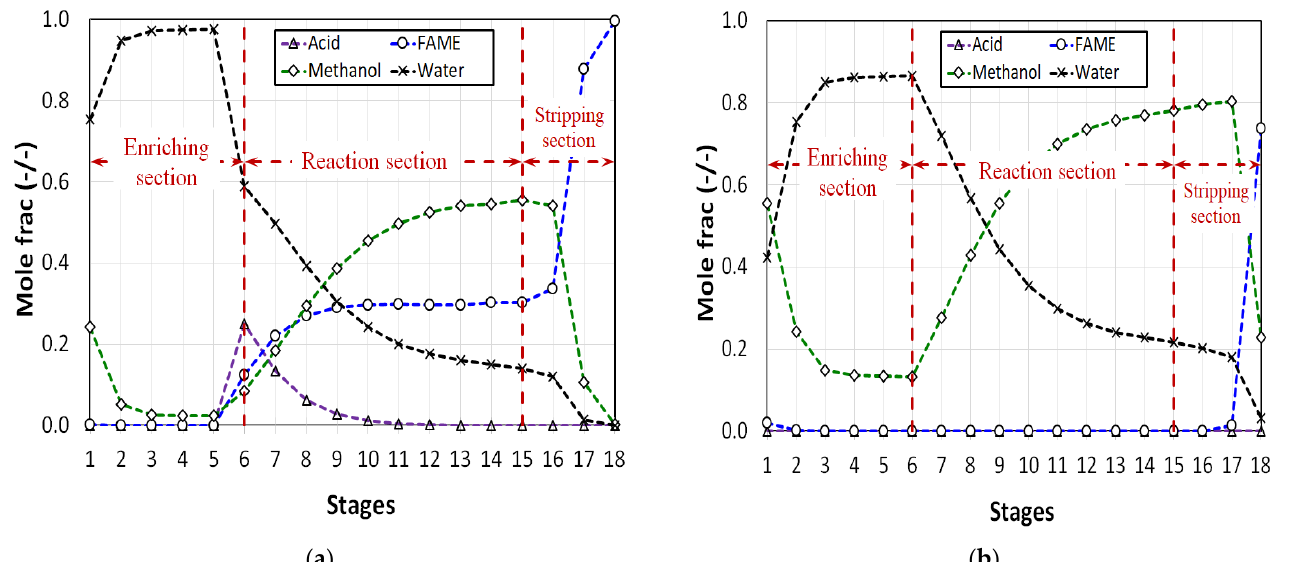
Figure 4. Stage composition profile of RD-column. ( a ) Liquid phase. ( b ) Vapor phase.